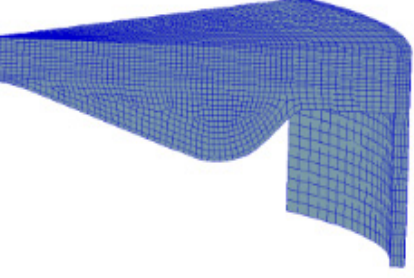
Figure 5. Computational grid of combustion chamber at TDC (top dead